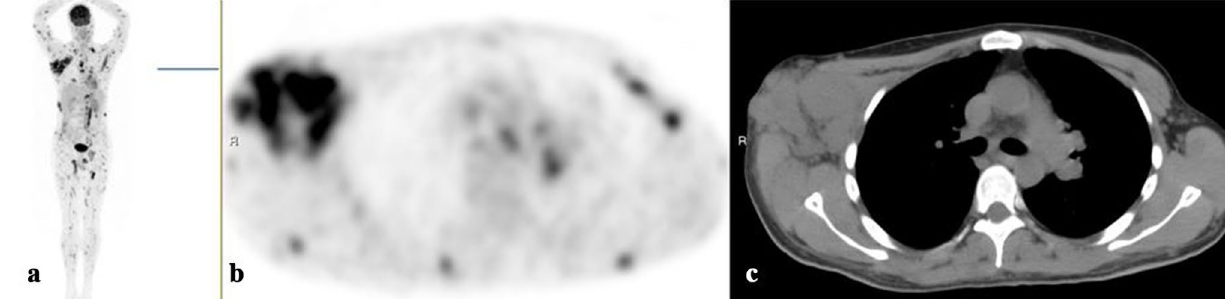
Figure 3. [18F]FDG-PET/CT: maximum intensity projection (MIP), (a) representative PET (b) and CT (c) axial slices. A 35-year-old man with melanoma diagnosed by a biopsy taken from the right axillary lymph nodes (A. b). Large lymph nodes in the right axilla and multiple [18F]FDG-avid soft tissue